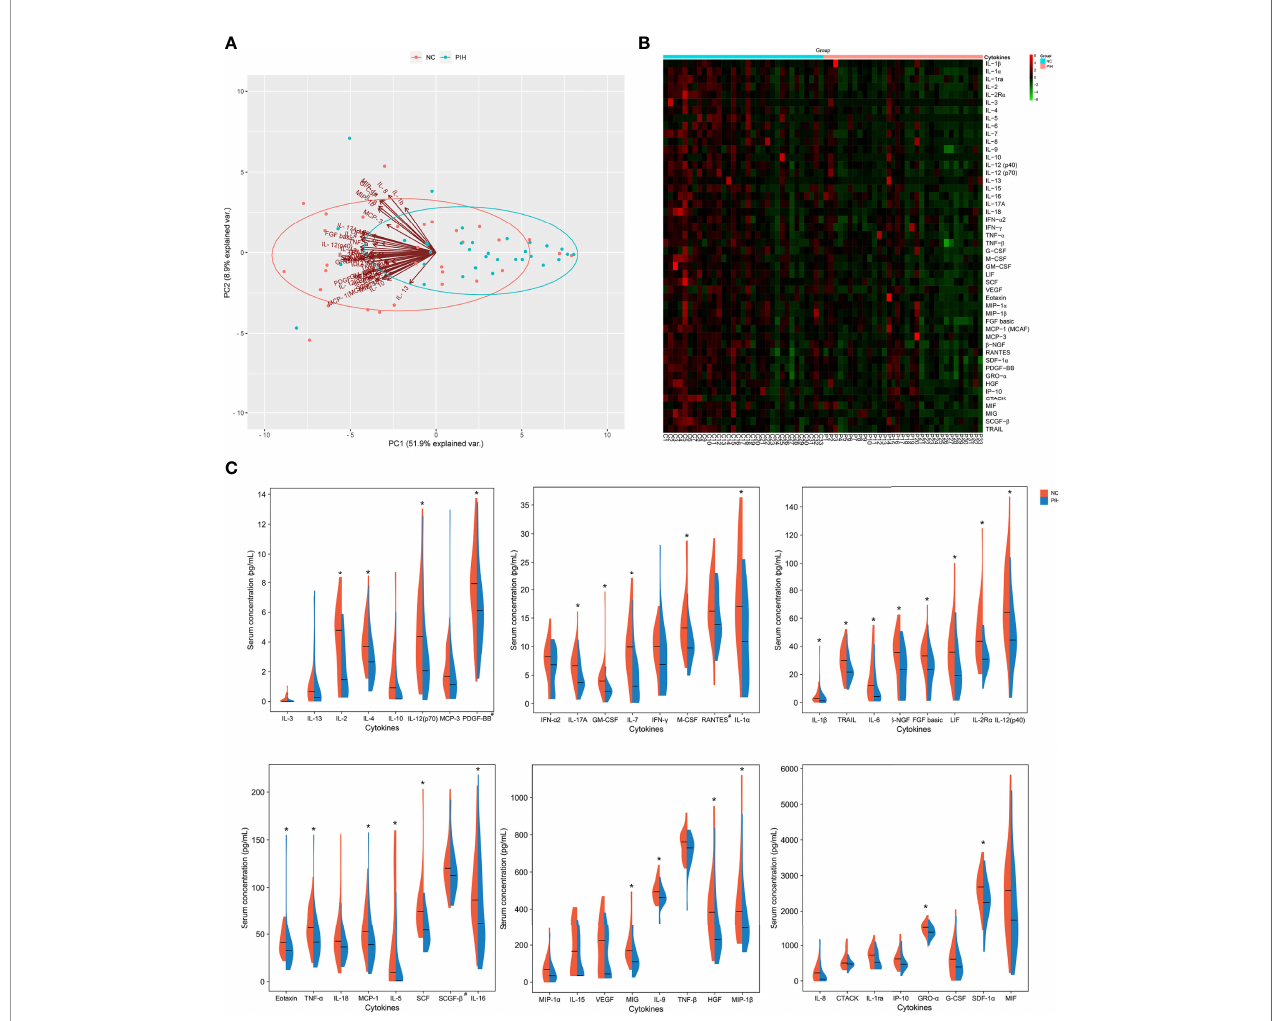
FIGURE 1 | Analysis of 48 cytokine pro fi les in the fi rst-trimester pregnancy serum of the NC group vs. the PIH group. (A) , PCA of 48 cytokine pro fi les in the fi rst-trimester pregnancy serum. The points in the diagram represent the samples, red for the NC group and blue for the PIH group. The arrows represent the contribution and correlation of the corresponding original variables to the principal component. (B) , Heatmap analysis of 48 cytokine pro fi les in the fi rst-trimester pregnancy serum. The row displays the cytokines, and the column represents the sample number. The color key represents the deviation of global median concentrations for each cytokine. These median values (homogenized to 0 and displayed in dark) were calculated after homogenization treatment and used as a cut-off to separate high and low cytokine concentrations. Color gradation from red to green indicates high to low cytokine concentrations, respectively, with homogenized values ranging from 6 to -6. (C) , Half-violin plots showing the expression distributions of 48 cytokines in the fi rst-trimester pregnancy serum between the NC group and the PIH group. Six boxes were plotted according to general cytokine concentrations. The ordinate indicates the serum concentration of cytokines, with pg/mL as the concentration unit, except for the concentration units of PDGF-BB, RANTES, and SCGF- b (marked by #) being ng/mL. Every different cytokine is shown as density (violin shap) and median value (horizontal lines) for NC vs. PIH. The left half (red) of each plot represents the NC group, and the right half (blue) represents the PIH group. Asterisk (*) represents a signi fi cant difference in cytokine expression in the fi rst- trimester pregnancy serum between the two